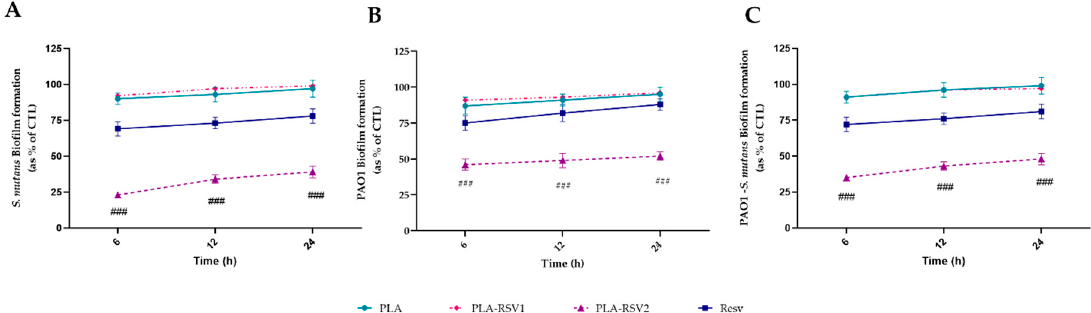
Figure 8. Antibiofilm activity of RSV-loading membranes. Biofilm formation was evaluated by crystal violet (CV) assay, after 6, 12, and 24 h of incubation at 37 °C in presence of ( A ) Streptococcus mutans , ( B ) PAO1, and ( C ) PAO1- S. mutans as described in the material and methods section. Biofilm formation was reported as a percentage in comparison with to the maximum amount of biofilm produced by Streptococcus mutans , PAO1, and PAO1- S. mutans grown (bacterial positive controls). A total of 200 μ M resveratrol was used as positive standard control (RSV). For each sample, six different experiments were conducted, and the results expressed as the mean of the values obtained (mean ± SD). Statistically significant variations: ### p < 0.001 versus RSV, PLA, and PLA-RSV1.